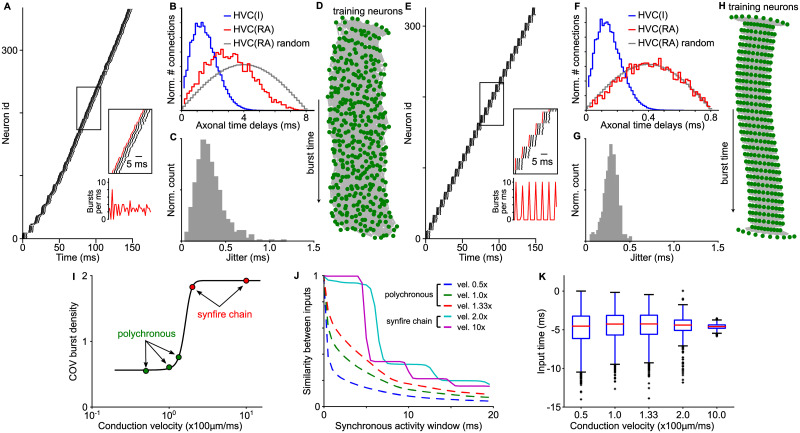
Axonal conduction velocity shapes network topology.A-D: Results for a network with conduction velocity 100 μm/ms, which corresponds to the realistic axonal delays in HVC. A: Raster plot of the first 150 ms of dynamics shows continuous coverage of burst onset times. B: Axonal time delay distributions for the HVCRA to HVCINT connections (blue), and the HVCRA to HVCRA connections that emerged during the wiring process (red). As a reference, the delay distribution for randomly connected HVCRA neurons is also shown (grey). The emerged connections show decrease in the number of long delay connections compared to the random connections. C: Jitter in burst onset times of a grown network. D: Network topology. Green dots are HVCRA neurons, and the gray lines are the connections. Neurons on top are the training neurons. The arrow indicate the direction or burst propagation. Only neurons with burst onset times within the first 150 ms are shown. The network has no apparent grouping of neurons. E-G: Results for a network with 10x faster conduction velocity 1000 μm/ms, which leads to near zero axonal delays. E: The network dynamics has prominent synchronous oscillatory activity. F: No bias towards shorter delay connections is observed in the grown network. G: The timing precision is in sub-millisecond range. H: Network topology reveals groups of neurons with similar input and output connections, i.e. synfire chain layers. I: The coefficient of variation of the burst onset density shows transition from continuous to discrete activity pattern. J: Similarity of inputs for neurons bursting within synchronous activity window has plateaus for synfire chain networks and is smooth for continuous networks. K: Distributions of excitatory input times relative to burst onset time of the postsynaptic neurons for different conduction velocities. The inputs arrive at the postsynaptic neurons synchronously in all networks wired with different conduction velocities.